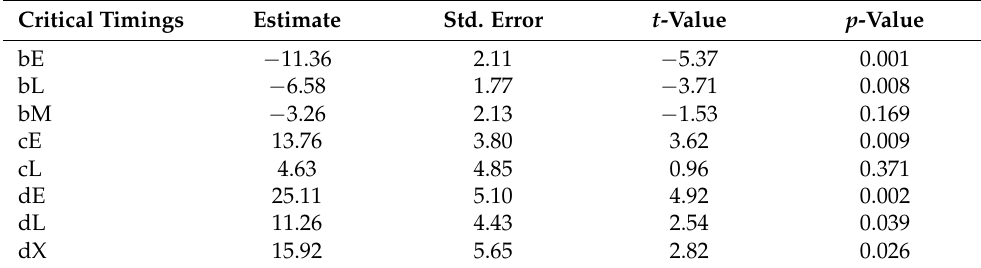
Table 2. Comparison of the critical timings of xylem formation for Picea crassifolia in Helanshan and Luoshan in 2019. bE, bL, and bM represent the beginning of cell enlarging, cell wall thickening, and mature phase, respectively; cE and cL represent the cessation of cell enlarging and cell wall thickening phase, respectively; dE, dL, and dX represent the duration of cell enlarging and maturing phase, and the total duration of xylogenesis, respectively. Critical Timings Estimate Std. Error t -Value p